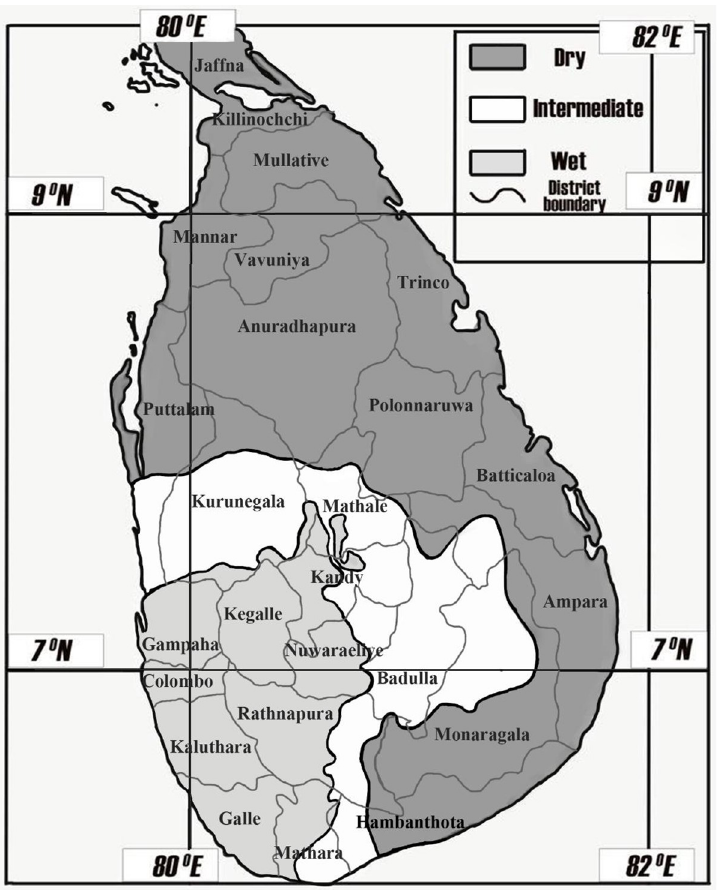
Fig 1. Distribution of climate zones and meteorological data collection centres in relation to administrative districts of Sri Lanka.